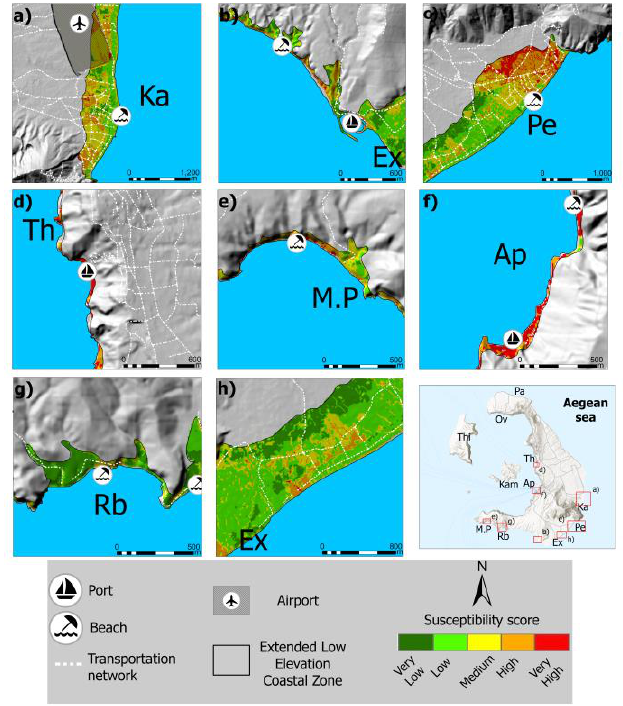
Figure 15. Map illustrating areas ( a – h ) prone to AHP multi-hazard results in Thira Island. Ka: Kamari, Pe: Perissa, Ap: Athinios, M.P: Mesa Pigadia beach, Rb: Red beach. Green color illustrates the areas with the lower susceptibility score and red color the higher, respectively. Table 11. Multi-hazard susceptibility statistics in Milos and Thira islands regarding the natural and manmade environments.